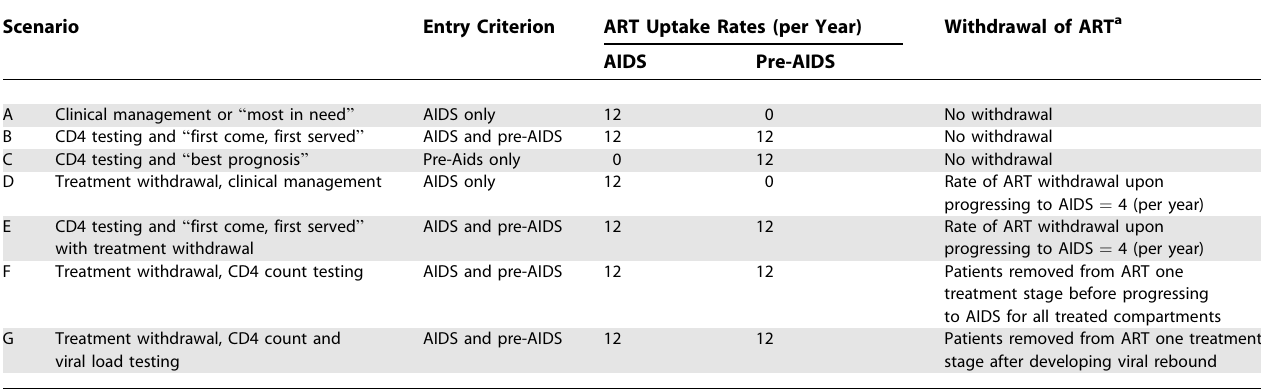
Table 4. Summary of Treatment Scenarios—Availability of Laboratory Facilities